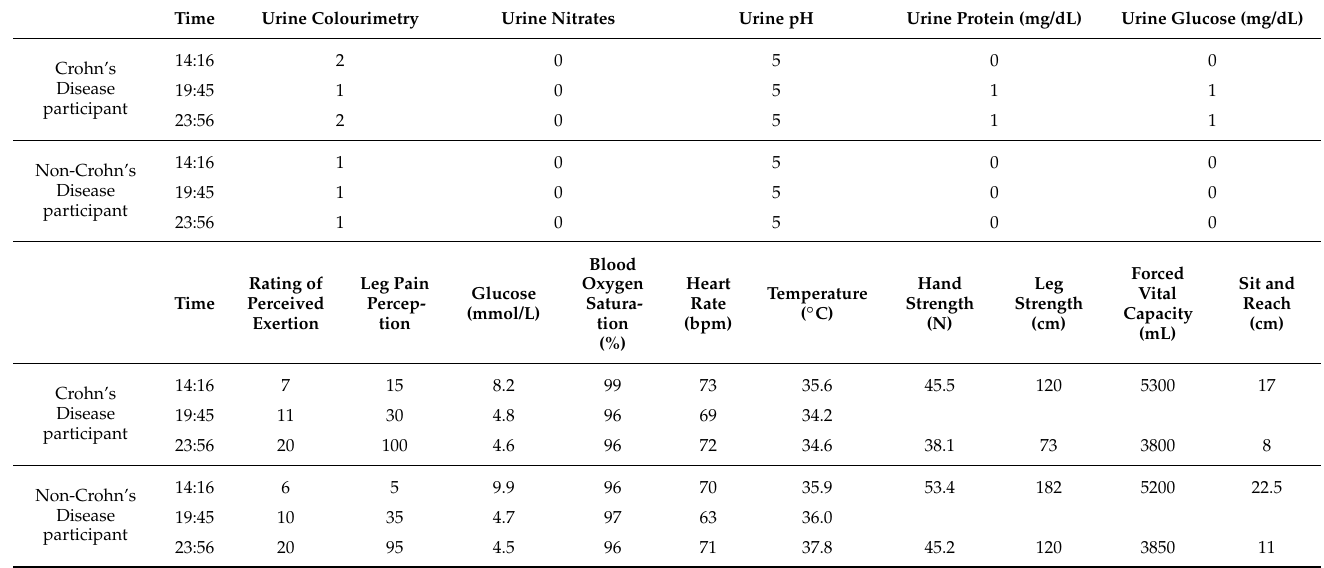
Table 2. Modification of study variables before, during, and after the ultra-endurance